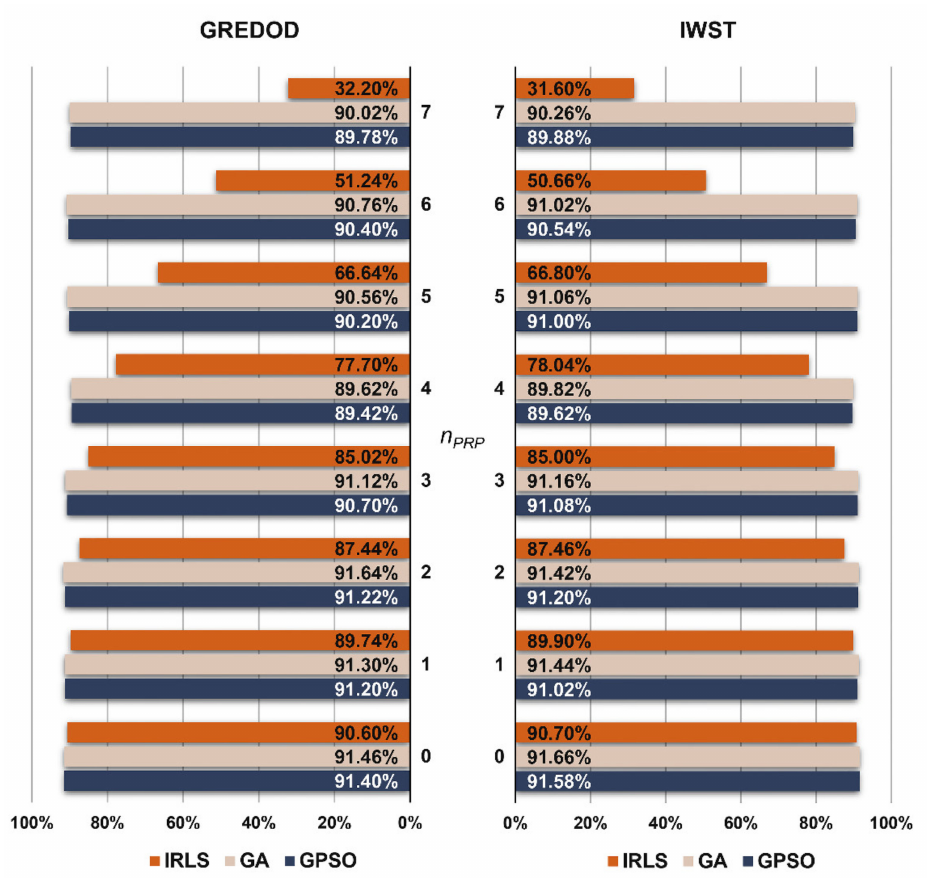
Figure 3. MSRs of GREDOD and IWST methods for variant